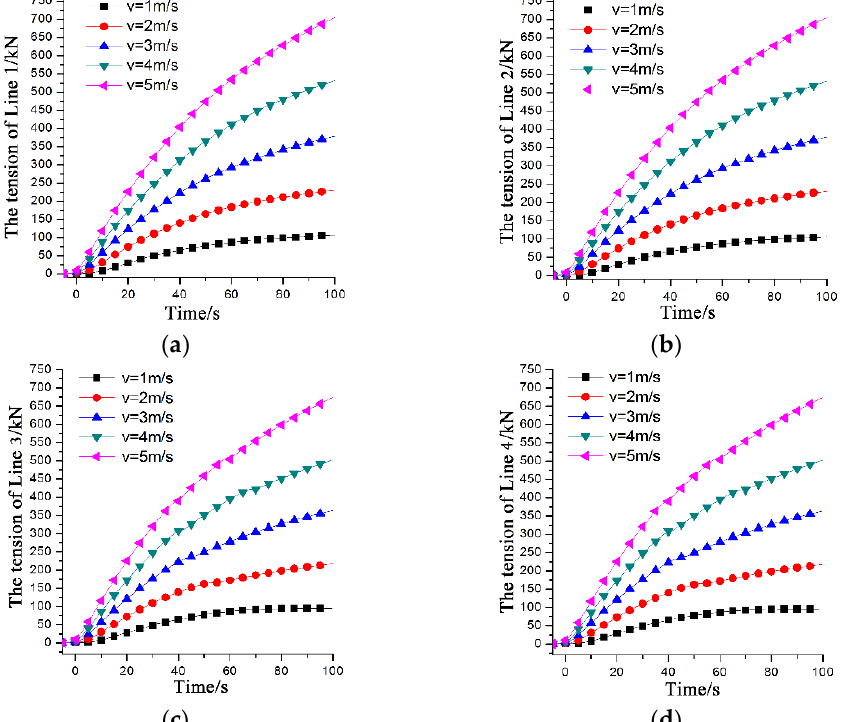
Figure 31. The time domain image of the cables ’ tension of the flexible trawl system in straight-line towing: ( a ) Line1; ( b ) Line 2; ( c ) Line 3; ( d ) Line 4.